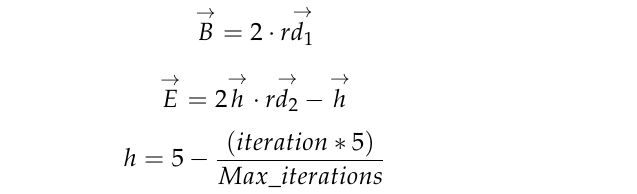
Figure 5. Searching for prey (| E | > 1). Figure 6. Attacking prey (| E | < 1).